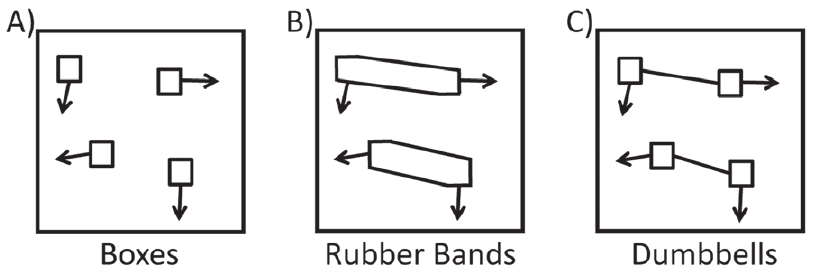
Figure 1. Some of the stimuli used by Scholl et al (2001). A) The boxes condition (i.e. the baseline condition). B) The rubber bands condition. C) The dumbbells condition. target-distractor oblongs continuously elongated and contracted. A